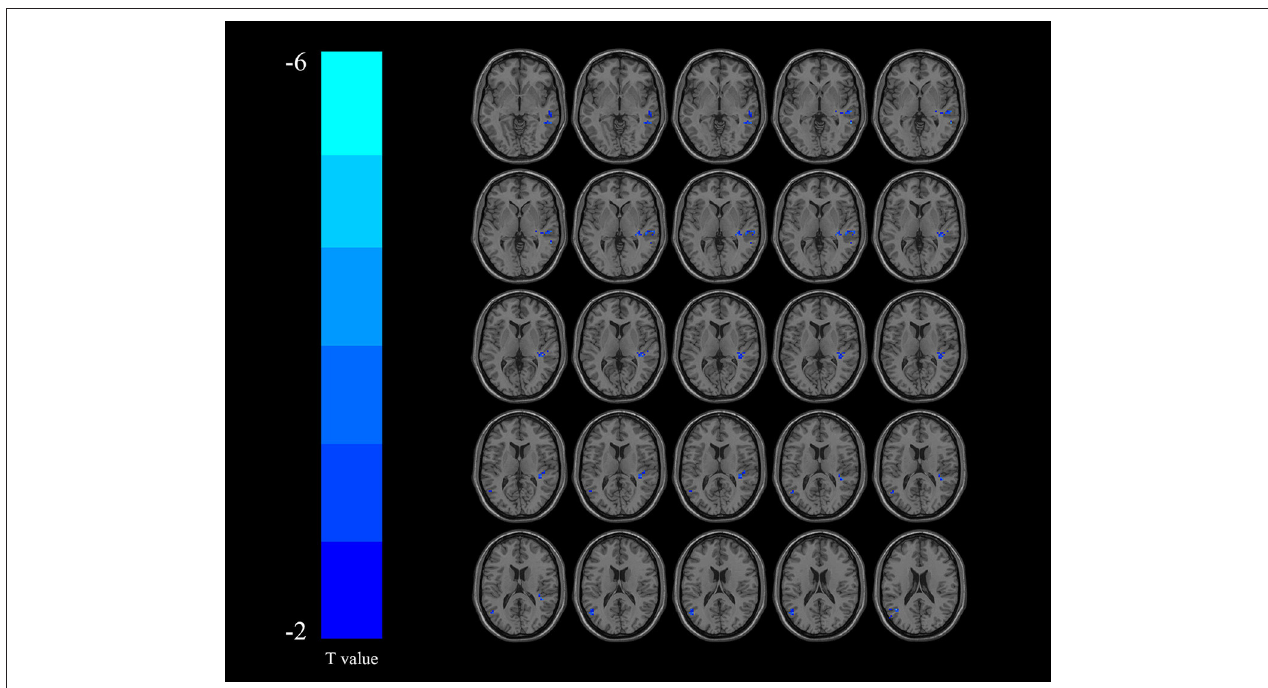
FIGURE 3 | Regions exhibiting differences in fractional amplitude of low-frequency fluctuation (fALFF) between the dysphagia after cerebral infarction (DYS) and non-DYS groups [ p < 0.001 corrected by Gaussian random field (GRF)]. Cooler colors indicate significantly lower regional homogeneity (ReHo) values in the DYS group.